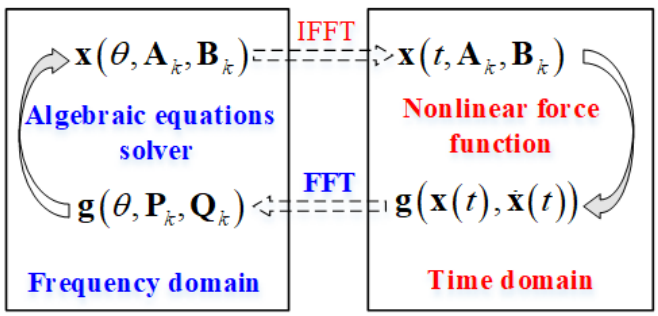
Figure 2. Principle of alternating frequency–time technique.